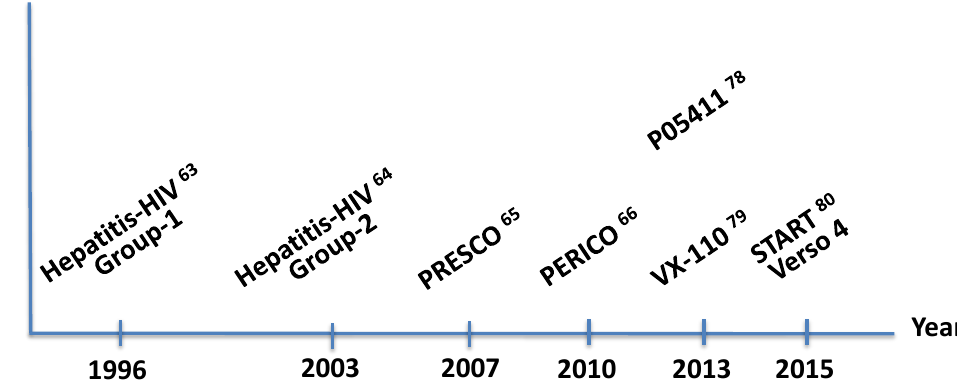
Figure 3. Major prospective clinical trials on treatment of hepatitis C in HIV coinfection led by Spanish